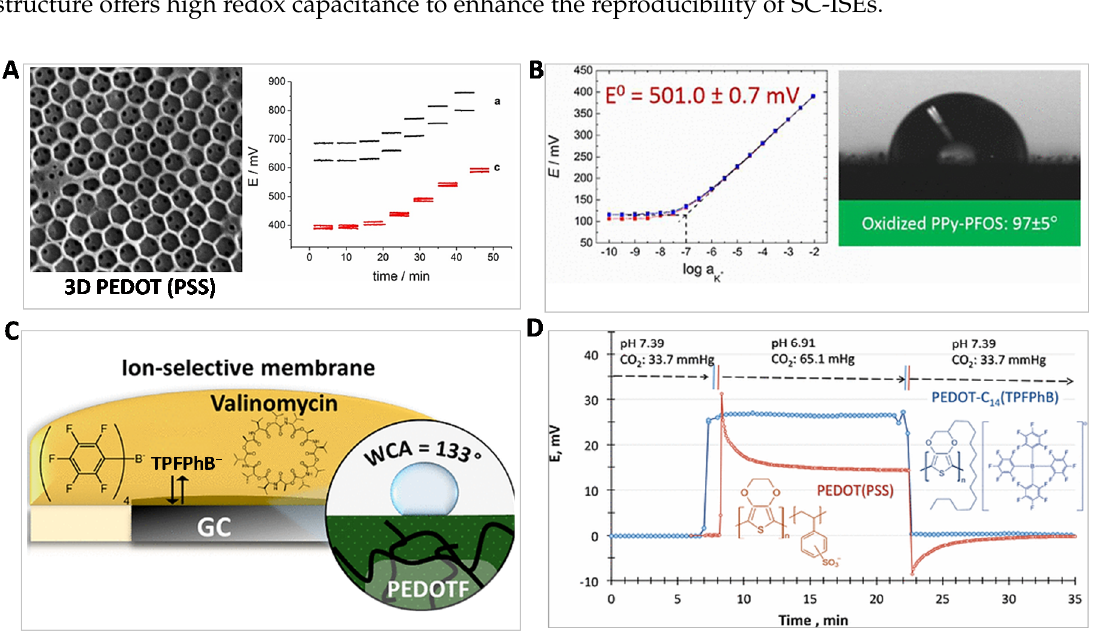
Figure 3. Structural design and functionalization of conducting polymers (CPs) for CP-based SC-ISEs. ( A ) Scanning electronic microscopy (SEM) image of the designed high-surface 3D poly(3,4- ethylenedioxythiophene) polystyrene sulfonate (PEDOT(PSS)) by nanosphere lithography and electrosynthesis. The right: the potential traces of 3D PEDOT(PSS) functionalized with (red line) and without (black line) a lipophilic redox 1,1′-dimethylferrocene. It is found that the functionalized 3D